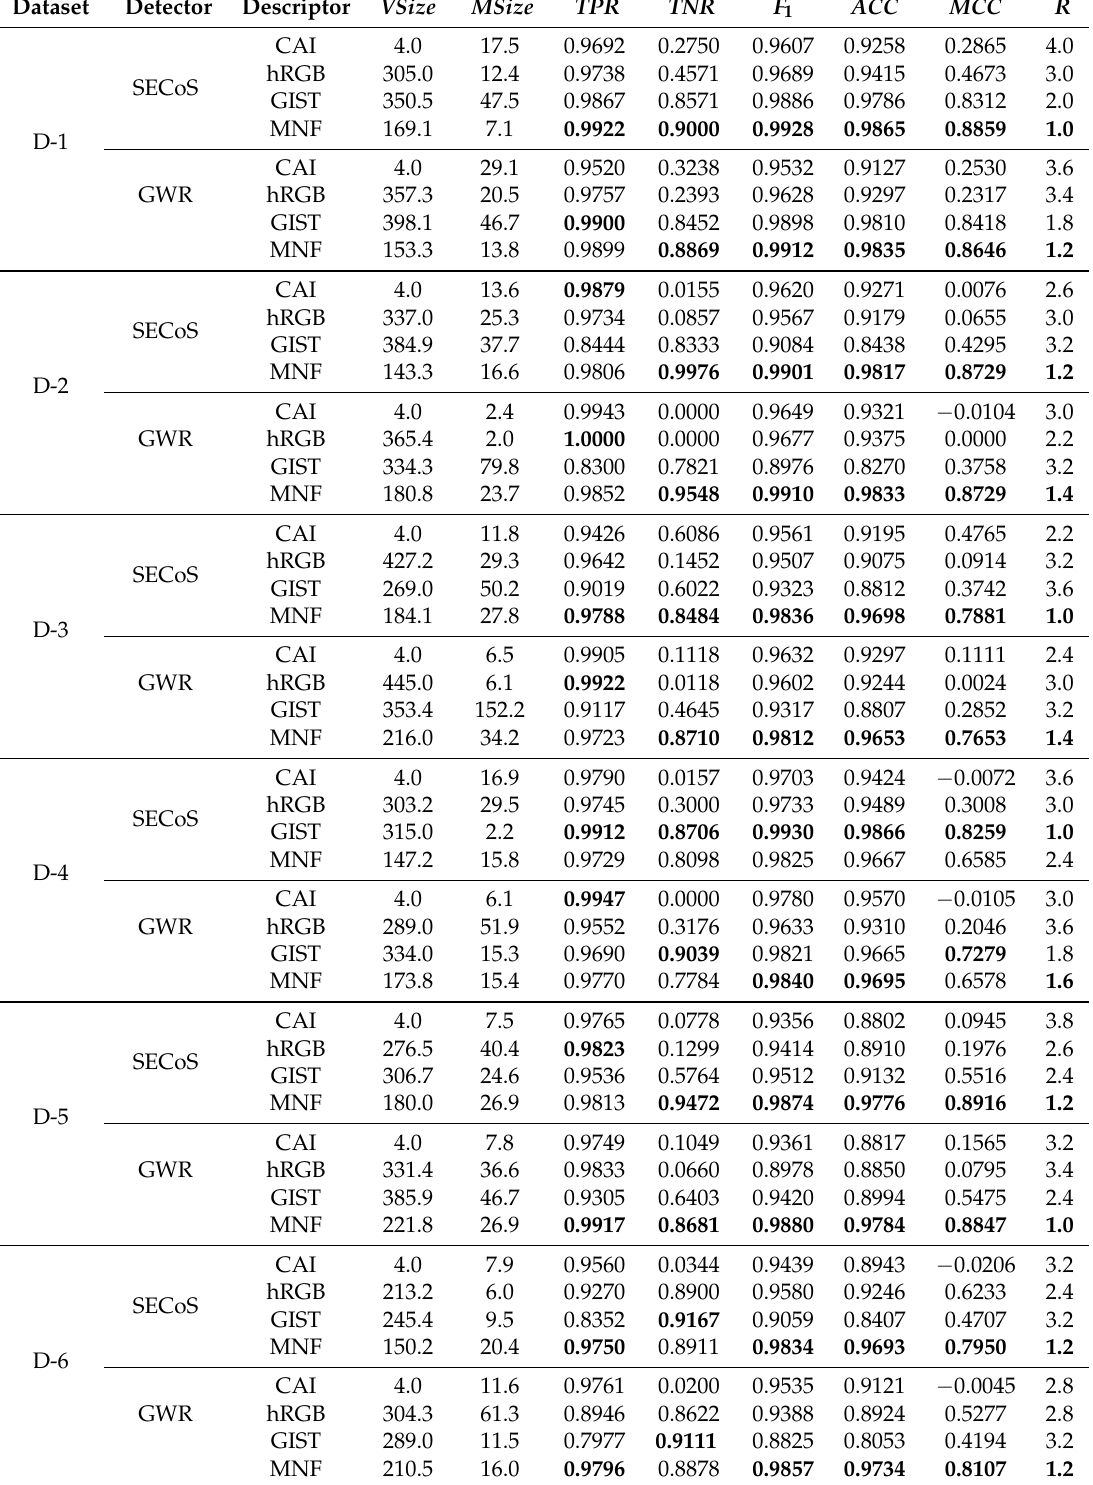
Table 5. Average results in the inspection phase over the 30 runs. Bold values indicate the best result for each metric according to the specific dataset and the specific novelty detector. CAI: color